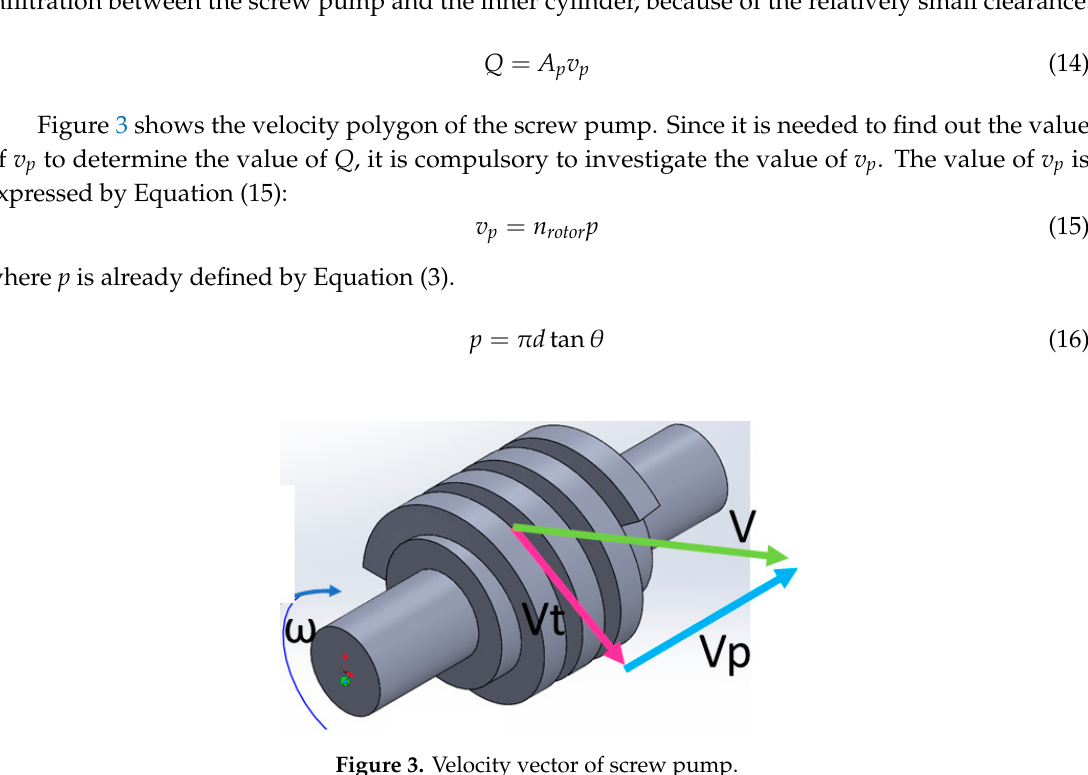
Figure 3. Velocity vector of screw pump.